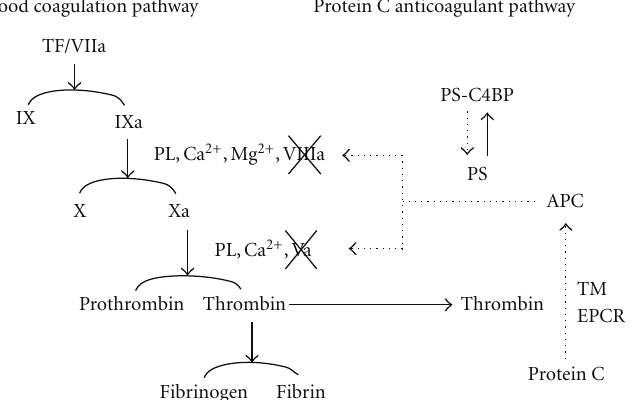
Figure 1: Blood coagulation pathway and protein C anticoagulant pathway . Thrombin, bound to thrombomodulin (TM), activates protein C which binds to endothelial protein C receptor (EPCR). Activated protein C (APC) inactivates coagulation factor Va (Va) and factor VIIIa (VIIIa) in the presence of protein S (PS). PS circulates in free form and in complex with C4b-binding protein (C4BP) in plasma, and the free form of PS plays a role as a cofactor of APC. TF: Tissue factor, PL: Phospholipids.